Question: Looking at the figure, what chart type is it?
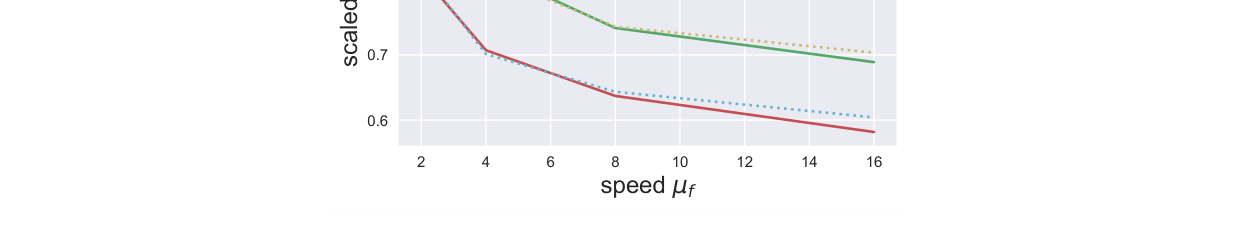
Answer: line